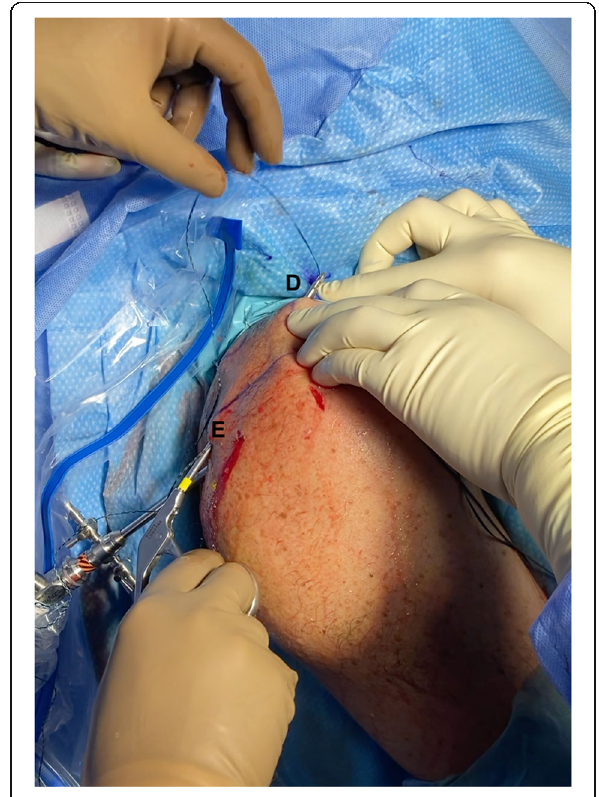
Fig. 4 A suture retriever is introduced from the posterolateral acromial incision (E), then slid along the superior surface of the acromion and out through the opposite anteromedial incision (D). The tape tail from this portal is retrieved back through the (E) incision, followed by the same step with the other tape (between incisions F and C). The corresponding tape tails of the same colour are then wrapped and tied around the superior surface of the acromion, in a crossed fashion and using a knot pusher